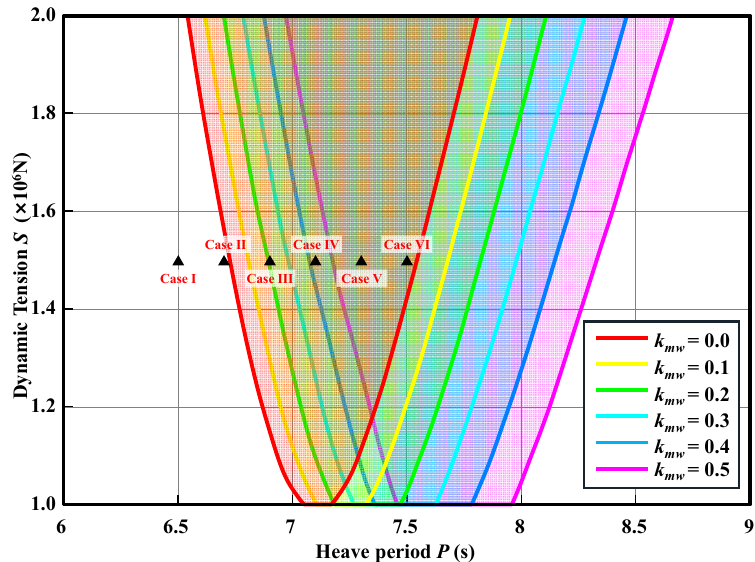
Figure 12. The locations of different cases in the instability chart. Table 3. Detailed parameters of different cases.